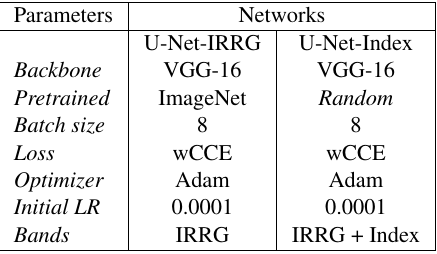
Table 2. Networks selected for single-time application on urban areas.